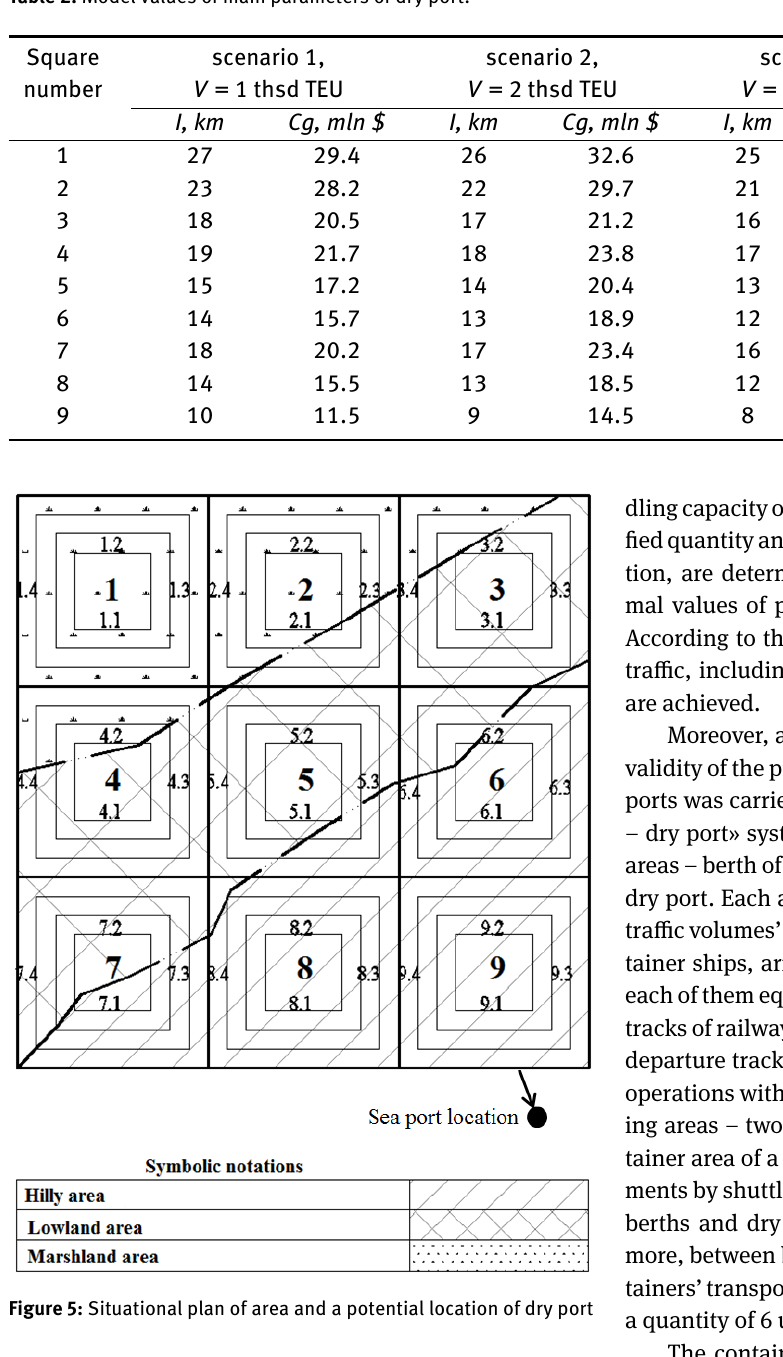
values of main parameters of a dry port. At each square of the potential dry port location 1, 2, ..., 9 border variants of dry port have shown, with different capacity – 1.1, 1.2, 1.3, ...